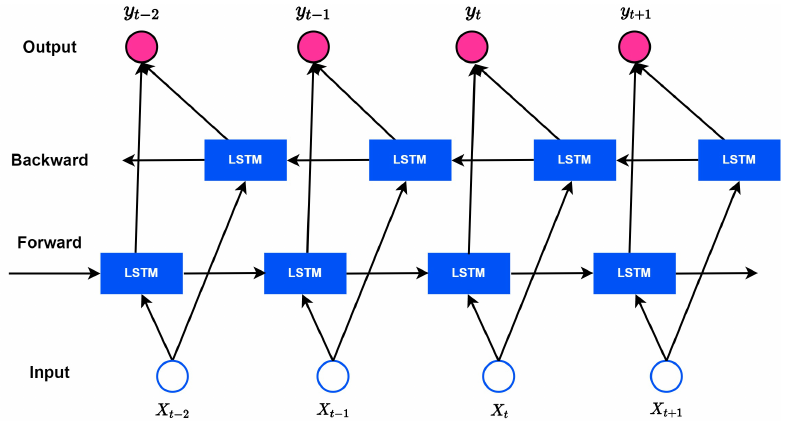
Figure 7. Overview of the BI-LSTM